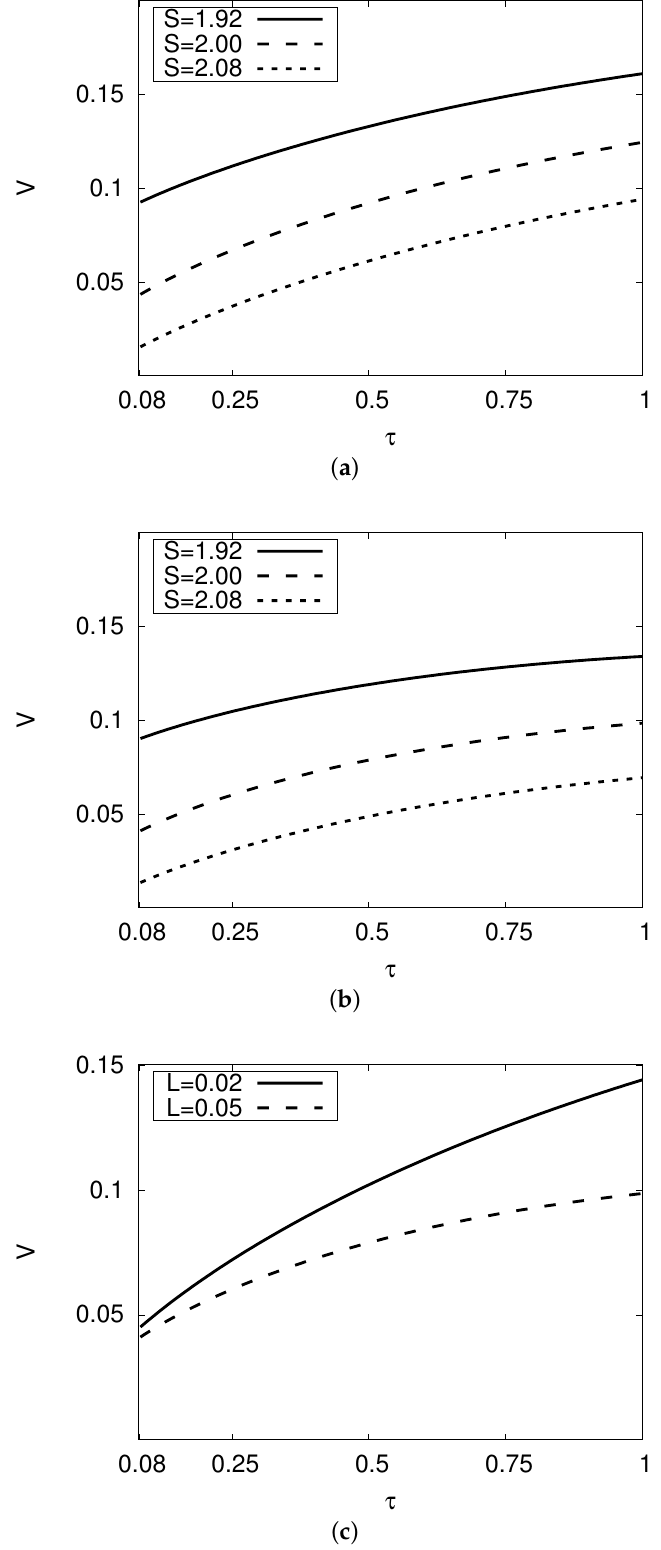
Figure 2. ( a ) European CI put ( V ) values with L = 0.02, ( b ) European CI put ( V ) values with L = 0.05 and ( c ) European CI put ( V ) values with S = 2 for various expiries ( τ ). Parameters used: r = 0.05, q = 0.04, σ = 0.2, X =